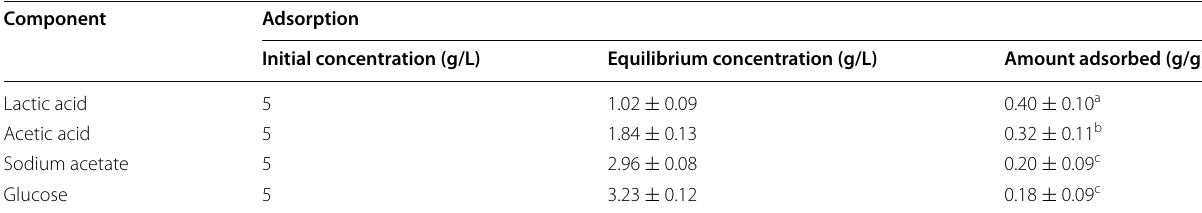
Table 6 Selectivity of Amberlite IRA 67 resin (10 g/L) towards lactic acid, acetic acid, glucose and sodium acetate